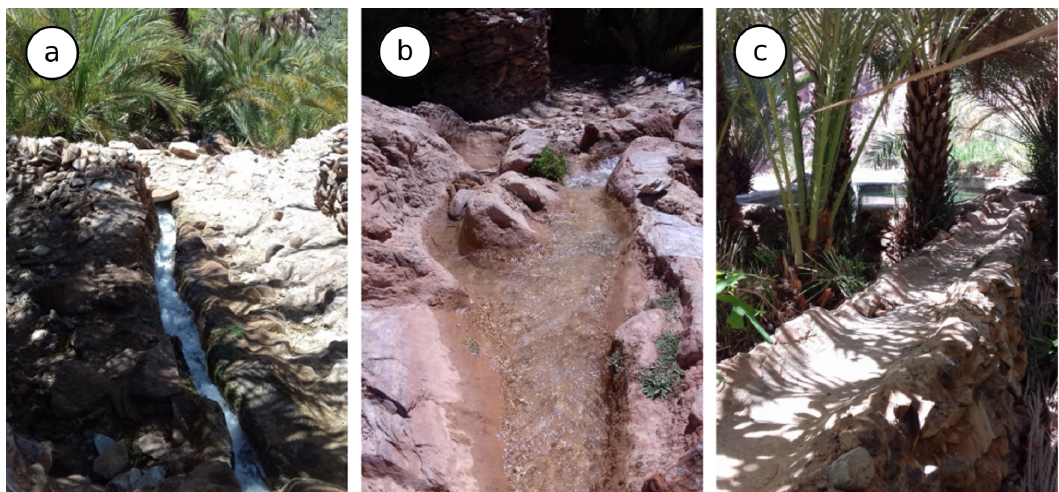
Figure A2. Traditional channels for water irrigation; the walls of the channels are covered by calcium carbonate natural deposits, due to the water filtration through the limestone in the basin. ( a ) A steep channel. ( b ) Bifurcation and repartition of the flow. ( c ) A horizontal channel built and naturally calcified on a dry stone wall.